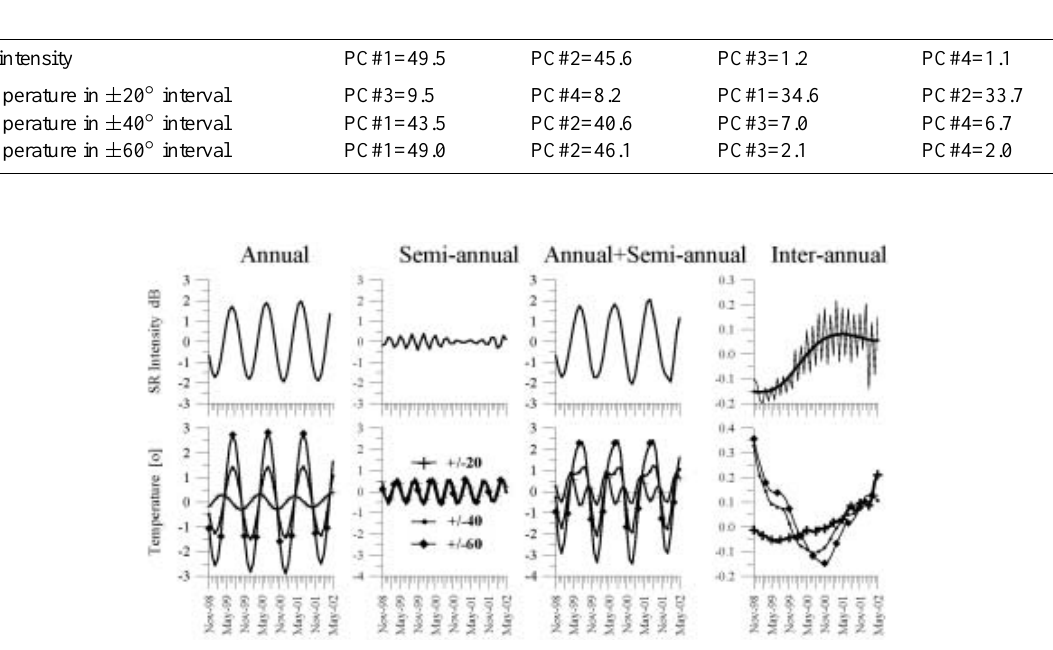
Fig. 6. Principal components: annual, semiannual, annual + semiannual, and interannual. The upper plots refer to the variations of the Schumann resonance intensity, and the lower plots demonstrate the variations of the global soil temperature in different latitude intervals.